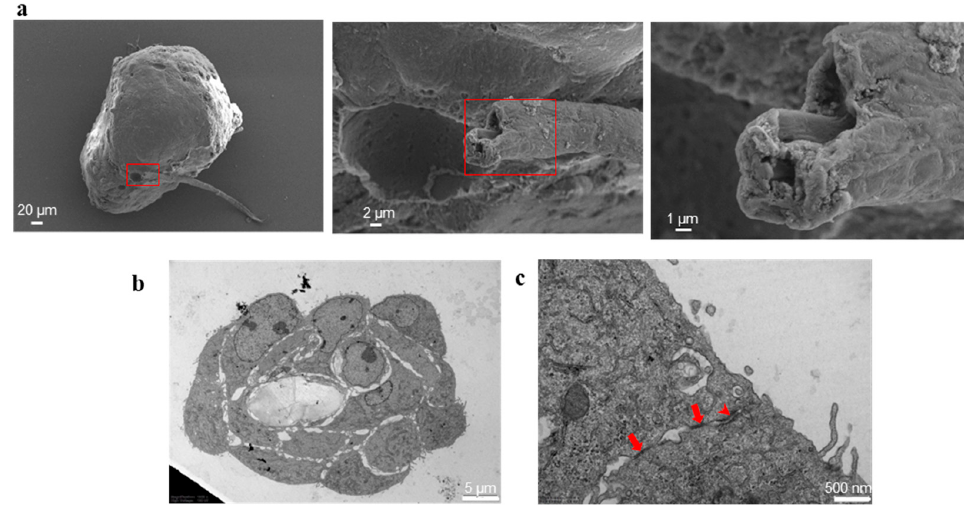
Figure 7. Lumen inside the vasculogenic mimicry-like tubules. ( a ): SEM images highlighting the tubule lumen; each red rectangle encloses the microscope field shown, in higher magnification, on the image on the right, highlighting the cavity of the tubule. The size bar is 20, 2 and 1 μ m, in order from the left to the right image. ( b ): TEM image of a sagittal section of the tubule, highlighting the hollow lumen delimited by cells. The size bar is 5 μ m. ( c ): representative TEM image showing the cellular junctions: the arrows point to tight junctions, the arrowhead points to desmosome. The size bar is 500 nm.